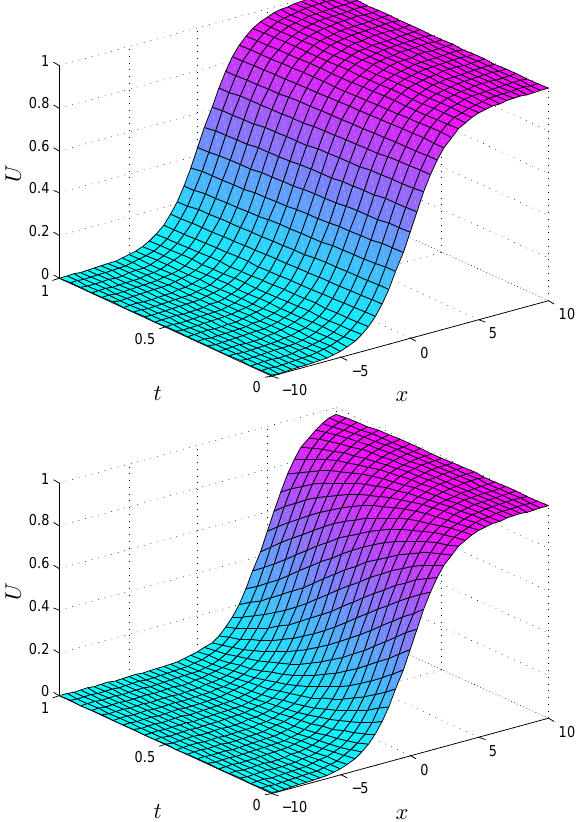
Figure 2. ( a ) Numerical solutions for q = 0.75; ( b ) Numerical solutions for q = 4 using the EEM for N = 41, t = 1 for Test Problem